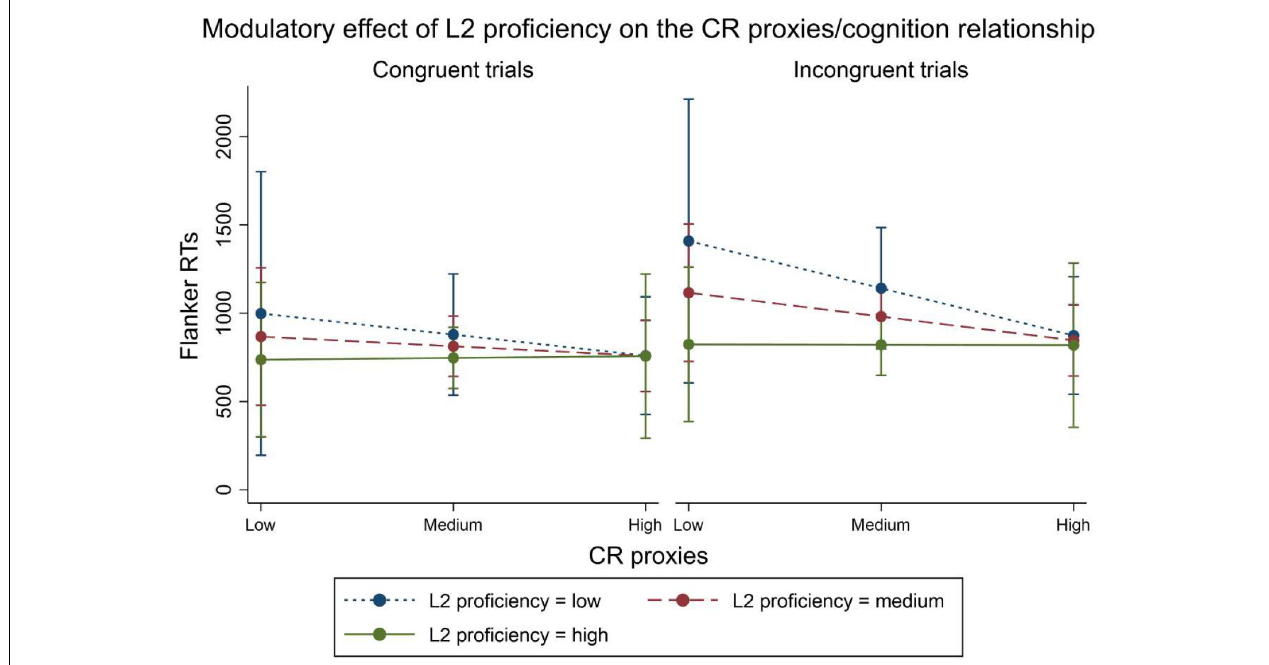
FIGURE 4 | Interaction plot for the L2proficiency*trial type*CR proxies interaction predicting Flanker RTs (in ms). Higher L2 proficiency entails lower RTs, i.e., better inhibitory executive performance. Increases in the CR proxies score predict lower incongruent RTs only at low levels of L2 proficiency. At increasing levels of L2 proficiency, variations of CR Proxies score do not affect executive